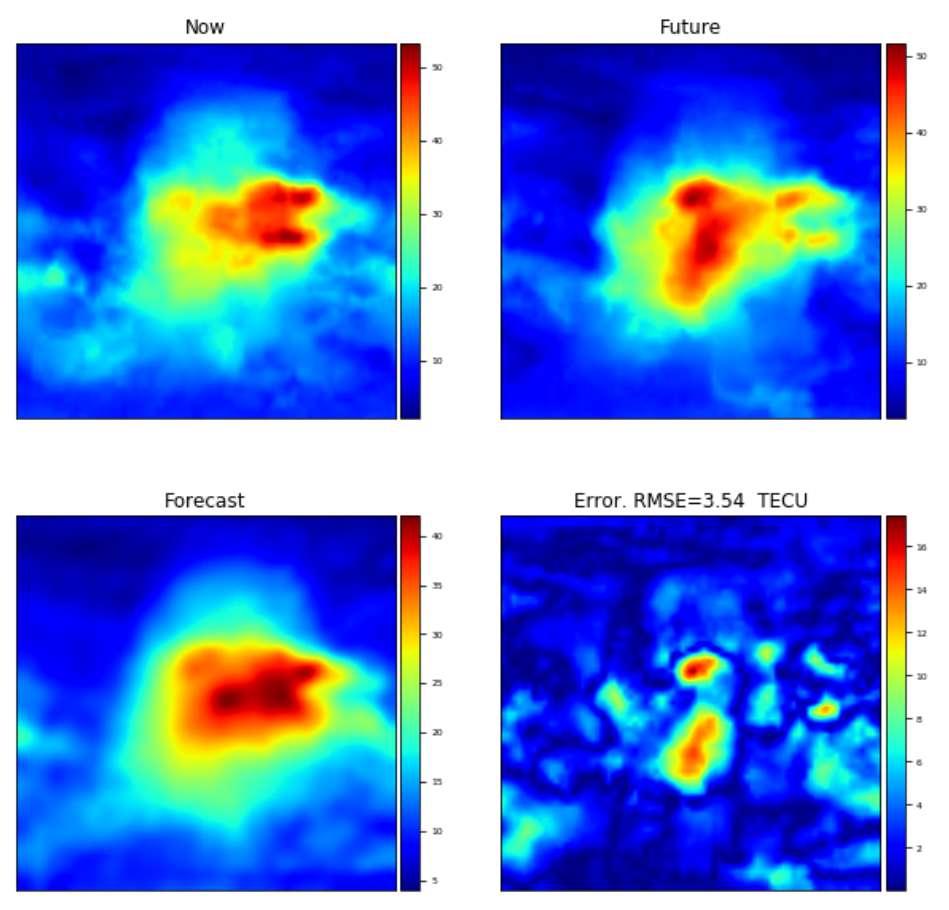
Figure 1. Forecasting by means of the DCT method at a horizon of 3 h. Time stamp, 2016-05-12 15:15:00 (Year-Month-Day Hour:Minute:Second): current map ( upper left ); future map ( upper right ); forecast ( lower left ); and forecast error ( lower right